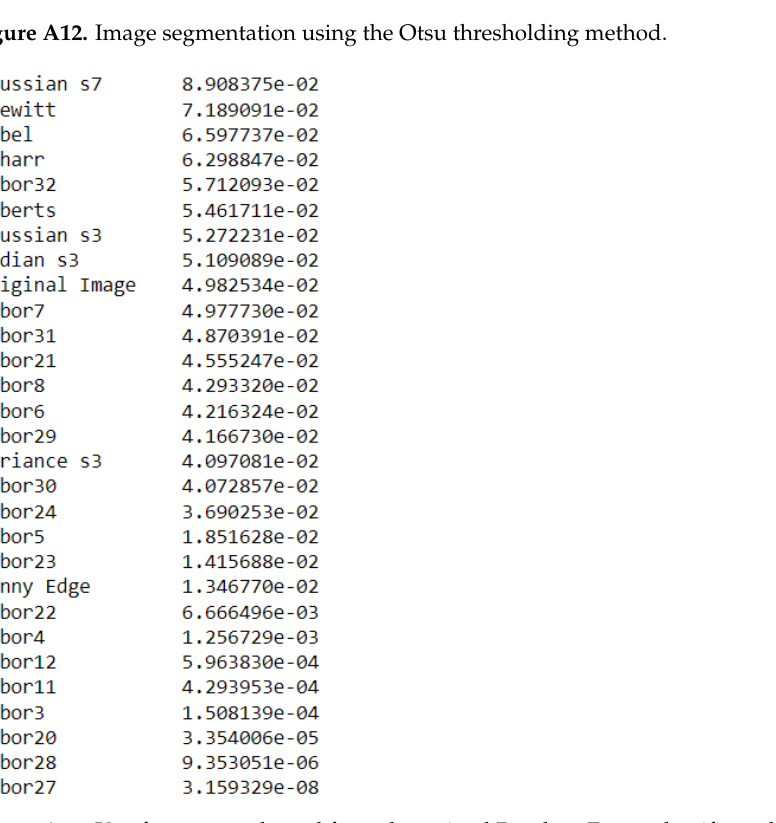
Figure A13. Key features evaluated from the trained Random Forest classifier, where the mean and standard deviation of the accumulation of the impurity decrease inside each tree are computed to determine the